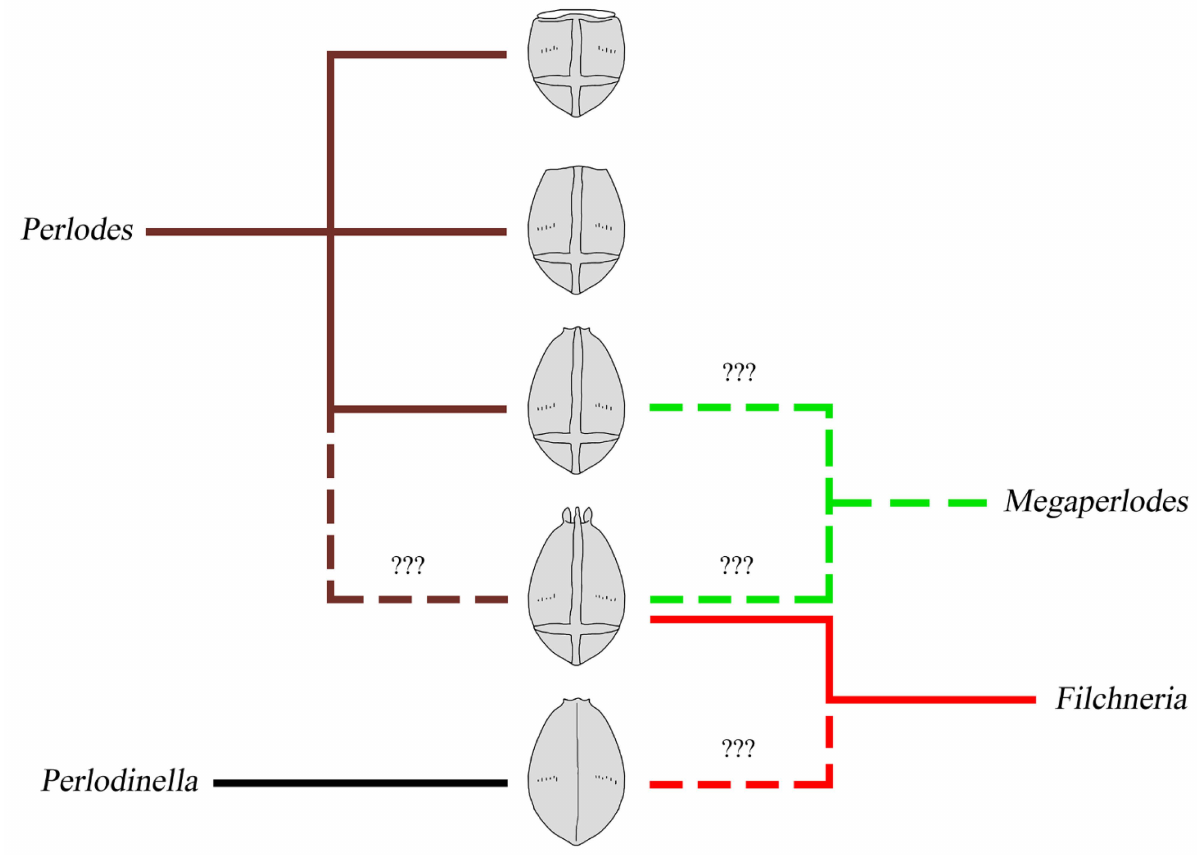
Figure 16. Egg morphology of four similar genera in Perlodini. The eggs of each genus are marked with a bold line in the recognized typical shapes and a dashed line in atypical